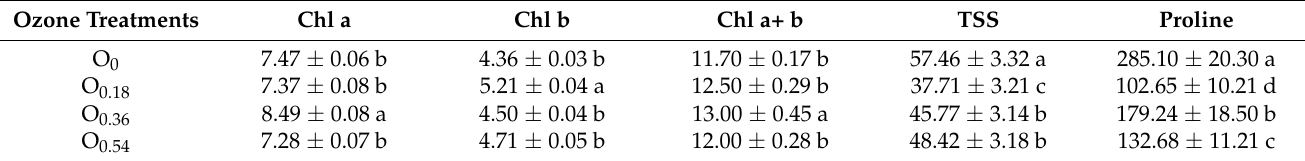
Figure 3. Interactions between fertigation treatments and O 3 supply on leaf total soluble sugars ( a ) and proline concentrations ( b ). The comparison between the ozone supplies is assessed with lowercase letters. Capital letters are used to analyze the comparability of fertigation treatments. Different letters denote significant treatment changes (LSD test, p < 0.05). Table 8. Effect of O 3 dosage on leaf chlorophyll a and b (mg g − 1 FW), TSS (mg g − 1 FW), and proline ( µ g g − 1 FW) concentration. The data recorded are the means ± standard deviation of four samples per treatment at the end of the experimental period. In each column, different letters denote statistically significant changes between treatments (LSD test; p < 0.05).